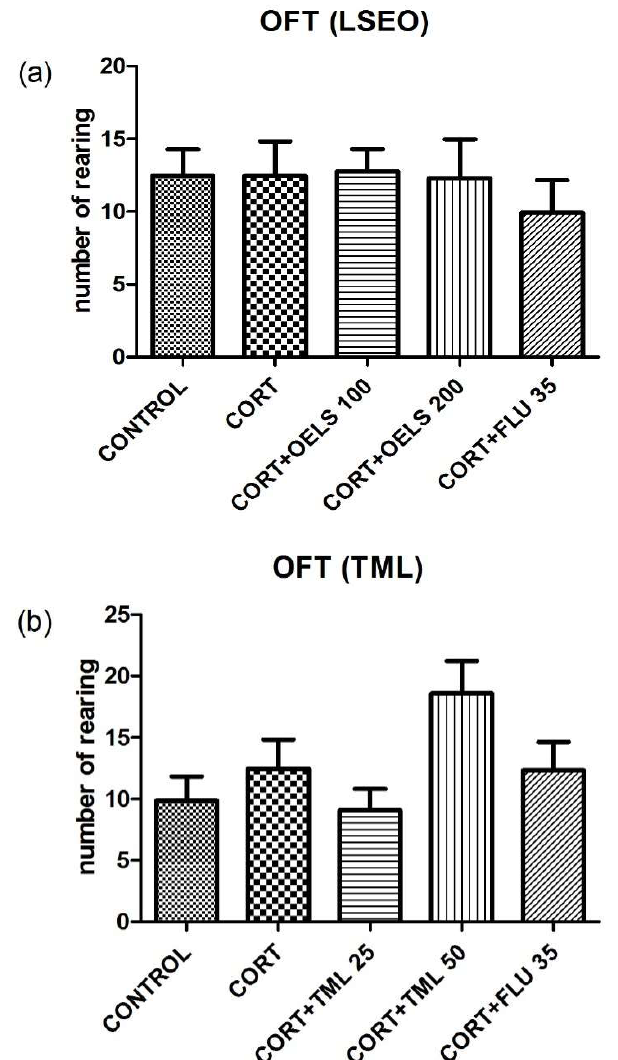
Figure 6. Effects of repeated administration of ( a ) LSEO (100 and 200 mg/kg; p.o.) and ( b ) TML (25 and 50 mg/kg; p.o.) in animals treated with CORT (22 days, 20 mg/kg, s.c.) on the number of rearings on the OFT. Values are expressed as the mean ± SEM ( n = 10). Statistical analysis was determined by one-way ANOVA followed by the Student-Newman-Keuls test. There are no significant values vs. CORT. LSEO = Lippia sidoides essential oil; TML = thymol; CORT = corticosterone; OFT = open field test.